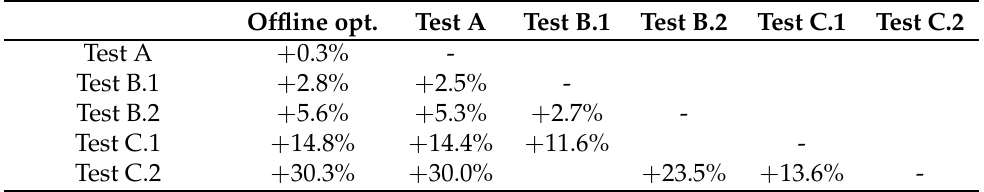
Table 4. Average increase in energy consumption between the different tests performed. Offline